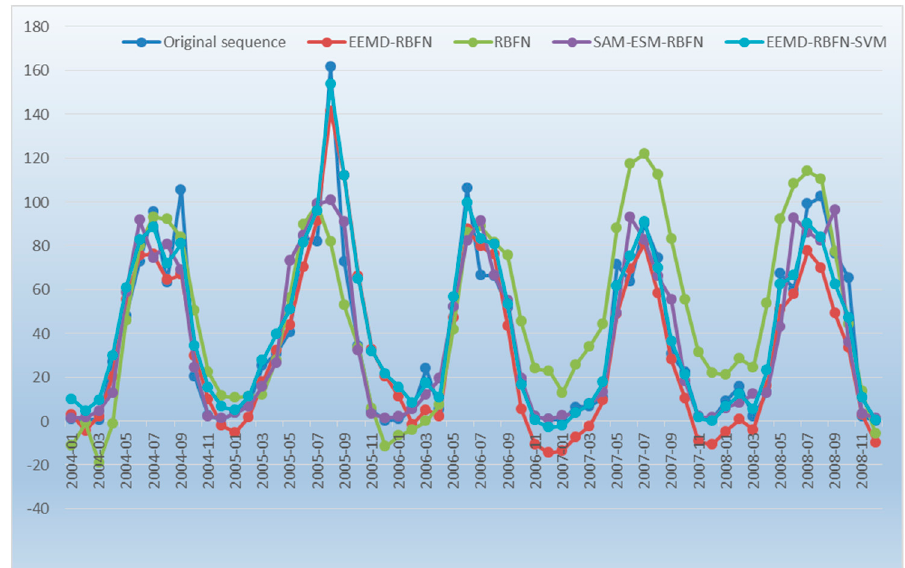
Figure 8. Comparison of prediction results.